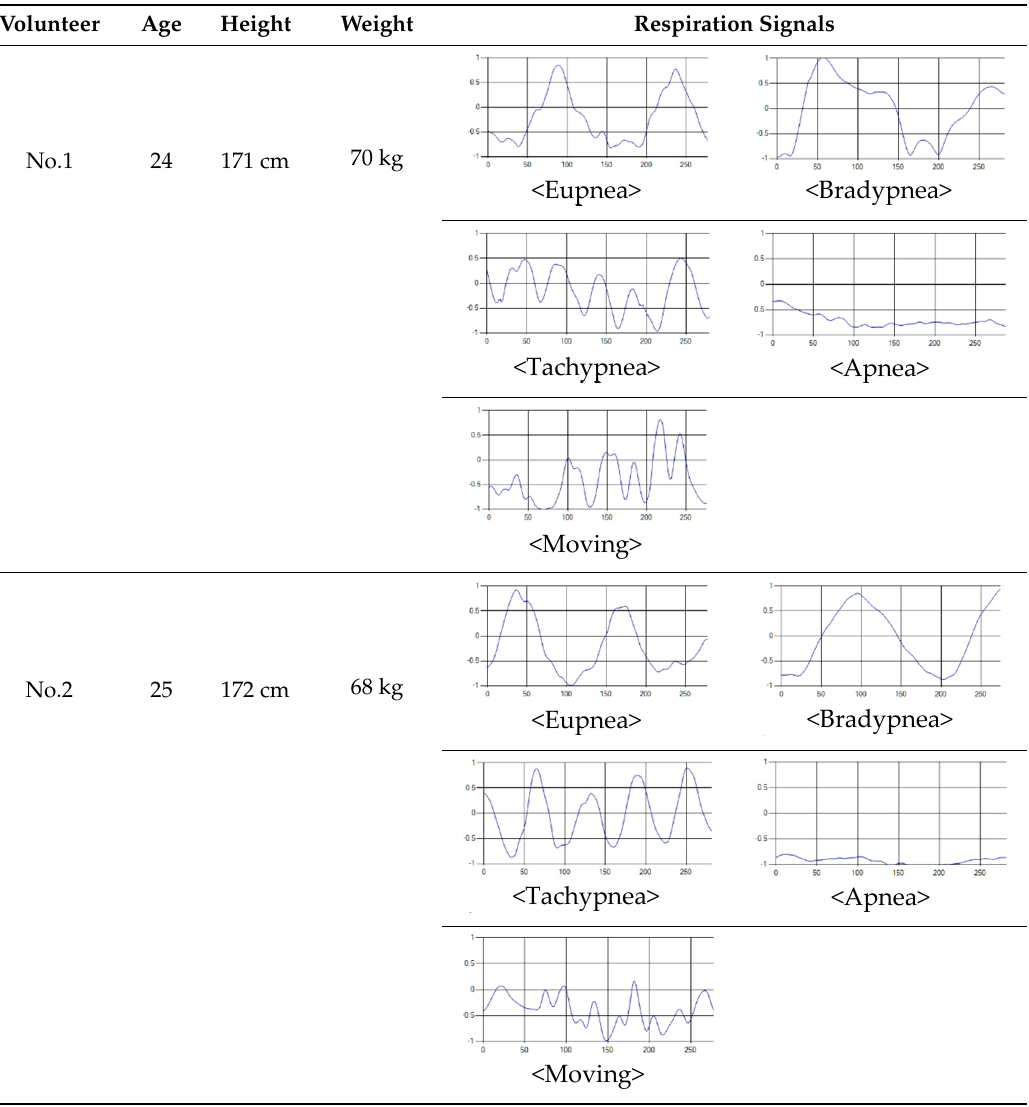
Figure 14. Construction of learning data by various time-shifting in one breathing pattern.